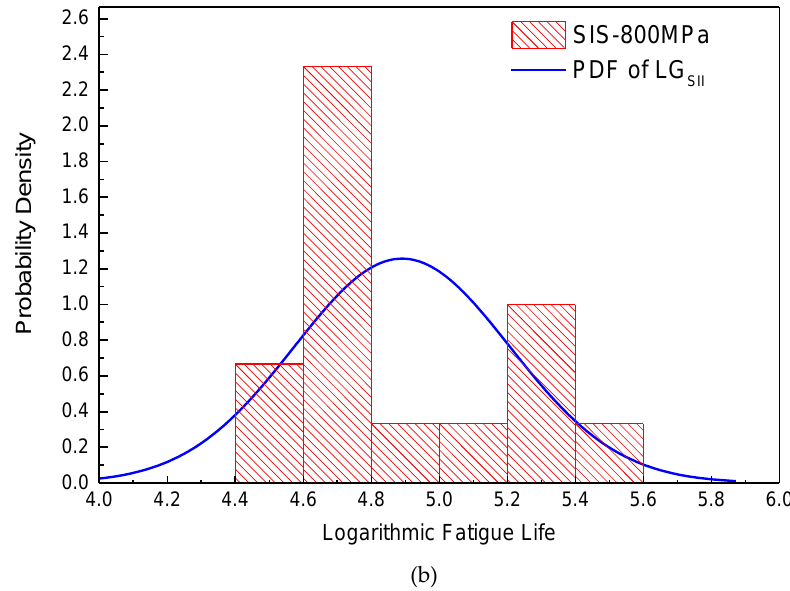
Figure 9. ( a ) FDH of SII under 720 MPa and its PDF; ( b ) FDH of SIS under 800 MPa and its PDF. Materials 2019 , 12 , x FOR PEER REVIEW